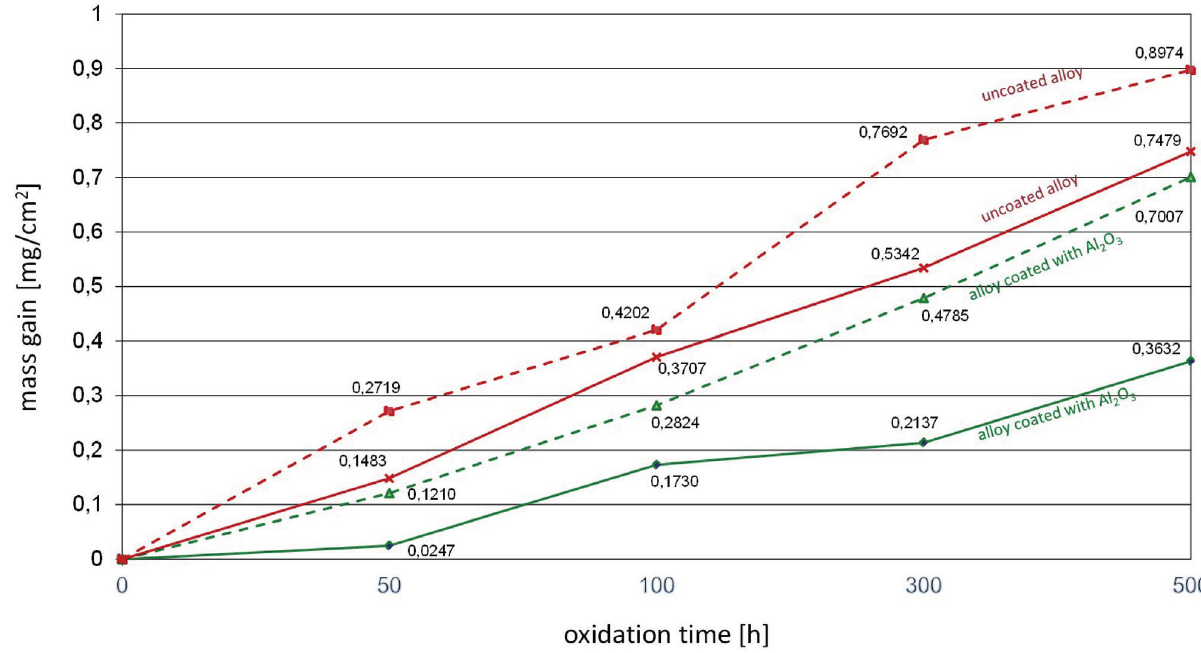
Fig. 4: The mass change of Ti-46Al-7Nb-0.7Cr-0.1Si-0.2Ni alloy coated with Al 2 O 3 oxidized isothermally at 750 °C in air (continuous lines) and